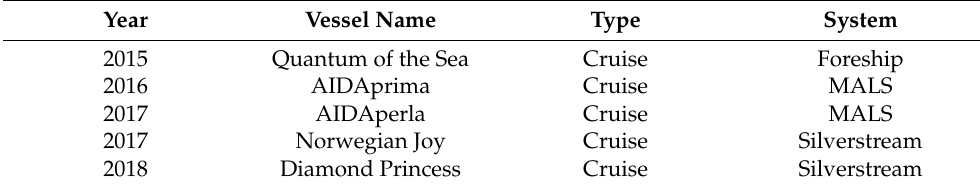
Table 1. The list of cruise vessels with Air Lubrication System delivered